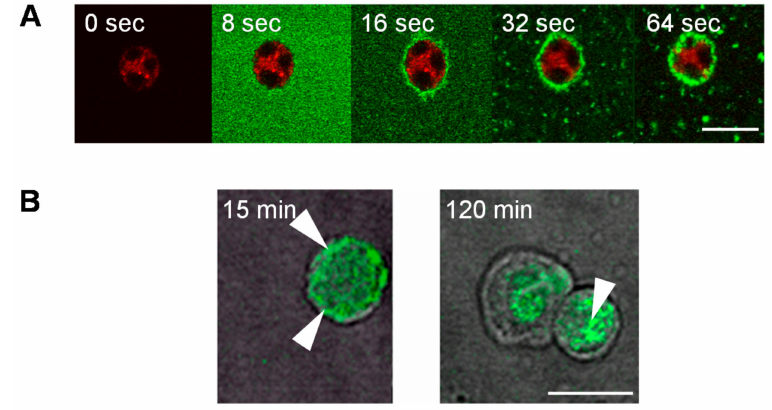
Figure 3. ( A ) Sequential images (64 first seconds) from confocal videomicroscopy of purified monocytes (with cytoplasmic labelling by orange 5-(and-6)-(4-chloromethyl(benzoyl)amino) tetramethylrhodamine [CMTMR]) incubated with the ABP dendrimer emitting green fluorescence, added at second 1. ( B ) Membranous and internal location at 15 min, but only in the intracellular location at 120 min of the ABP dendrimer (white arrows) seen in confocal microscopy; white bars indicate 10 µ M (adapted from [19]). Reproduced with permission from Poupot et al., FASEB Journal; published by the Federation of American Societies for Experimental Biology,